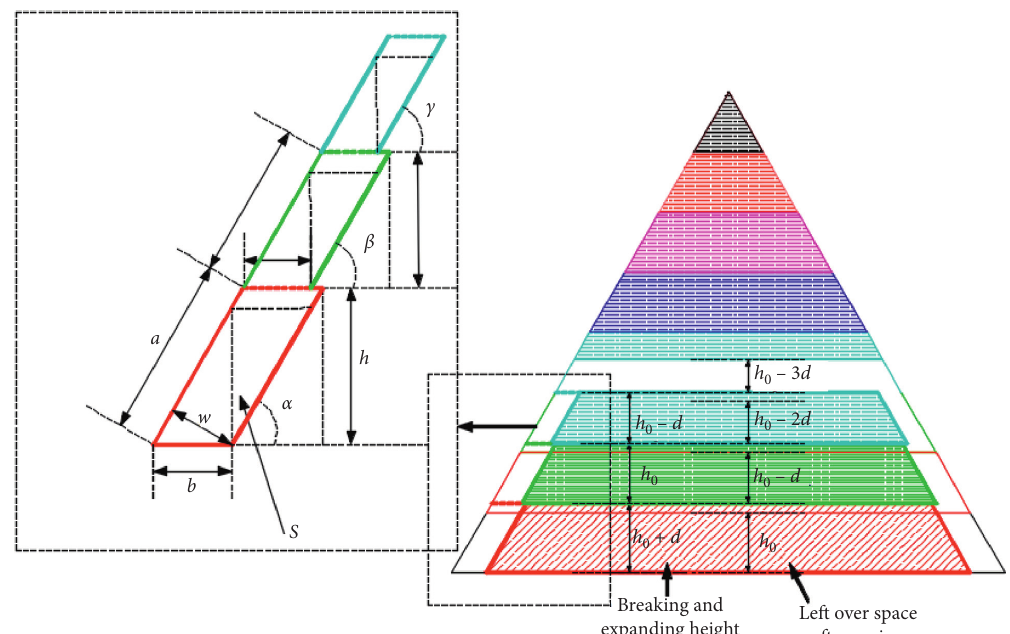
Figure 1: Schematic diagram of the parallelogram fractures generated at both ends of the trapezoidal broken model.